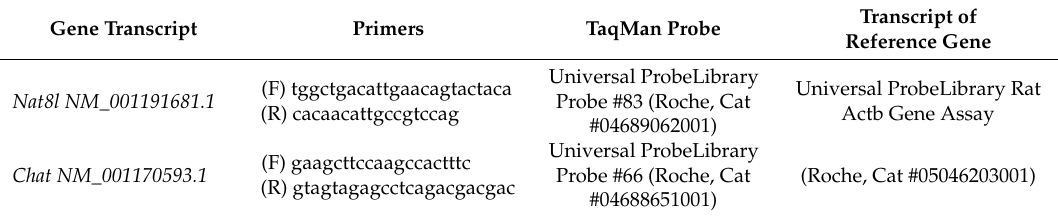
Table 4. A list of primers and TaqMan probes used in this